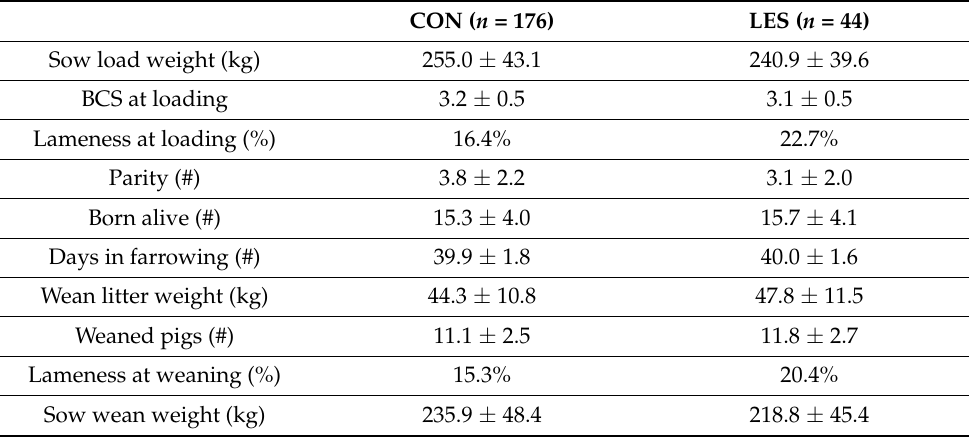
Table 2. Descriptive statistics for sow loading data, litter data, and sow weaning data for sows that developed a shoulder lesion (LES) and control sows (CON). Results are presented as mean plus or minus standard deviation. Sows were weighed when loaded into farrowing at day 109 of gestation and given a body condition score at that time. Born alive refers to the number of piglets born in the litter minus those that were stillborn or mummified. The parity is the parity post-farrowing. Number of weaned pigs is defined as the number of piglets weaned by that sow. Days in farrowing is the total time that the sow was in the farrowing room from loading to weaning. The wean litter weight refers to the total weight of all the piglets in the litter at